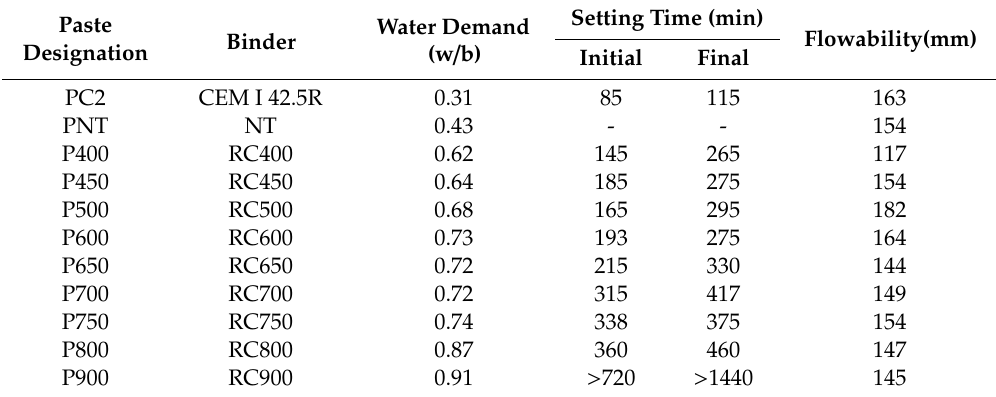
Table 5. Water demand and setting time of PC and RC, and flowability of the